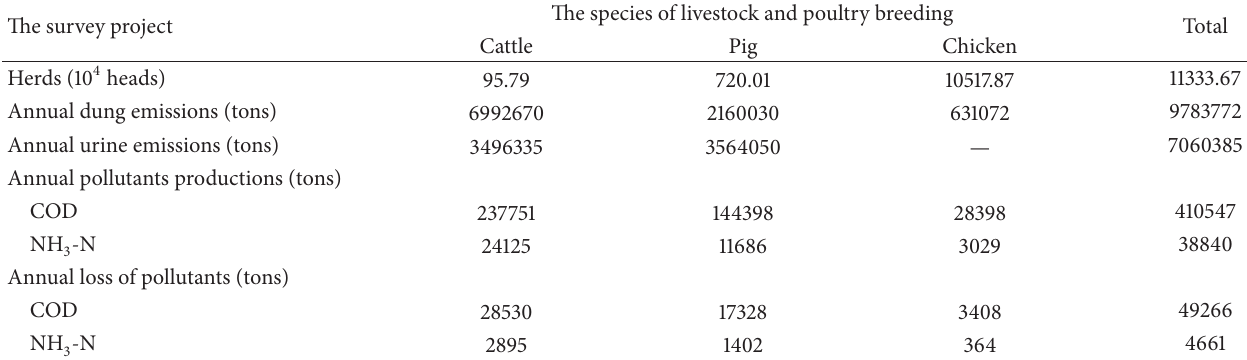
Table 4: The situation of livestock and poultry breeding industry in the Nansi Lake